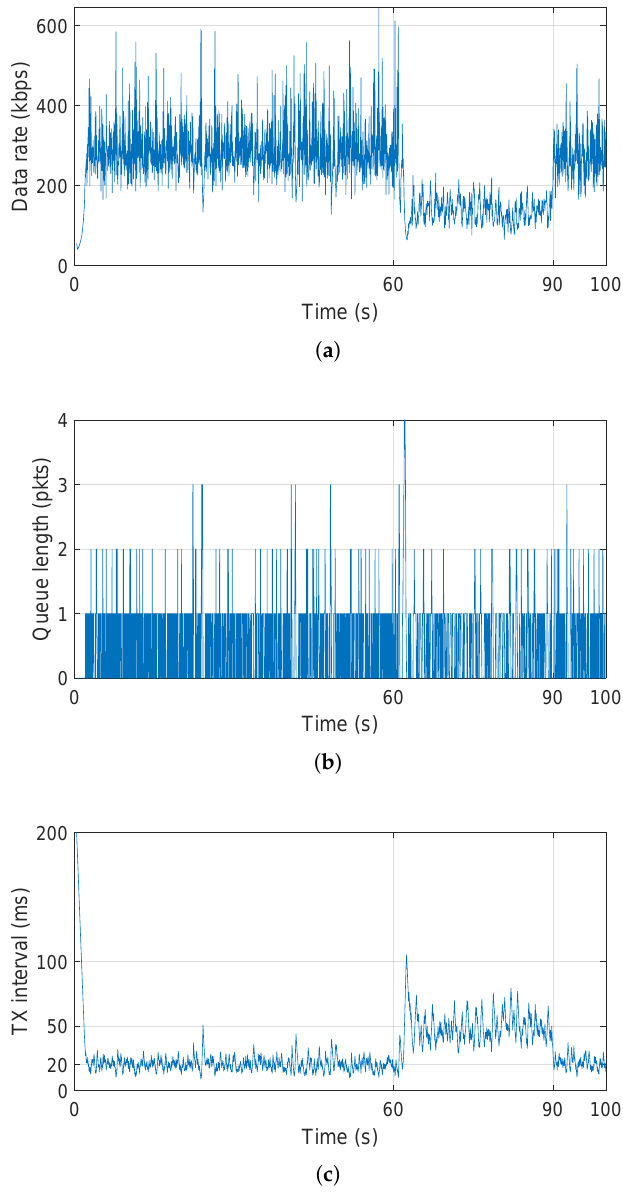
Figure 10. Network-aware UDP application’s ( a ) data rate, ( b ) queue length on the other end as indicated in received INT report and ( c ) transmission